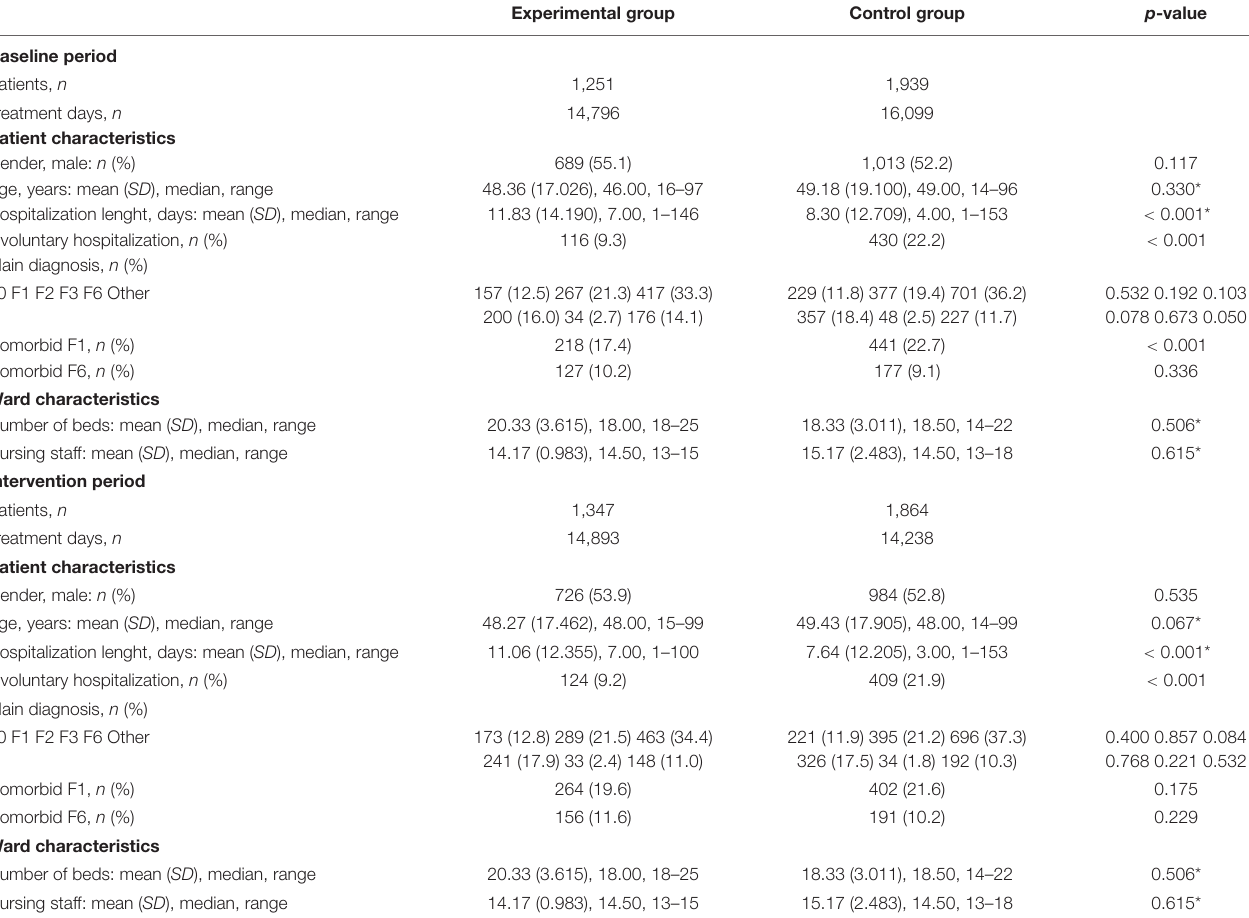
TABLE 2 | Patient and ward